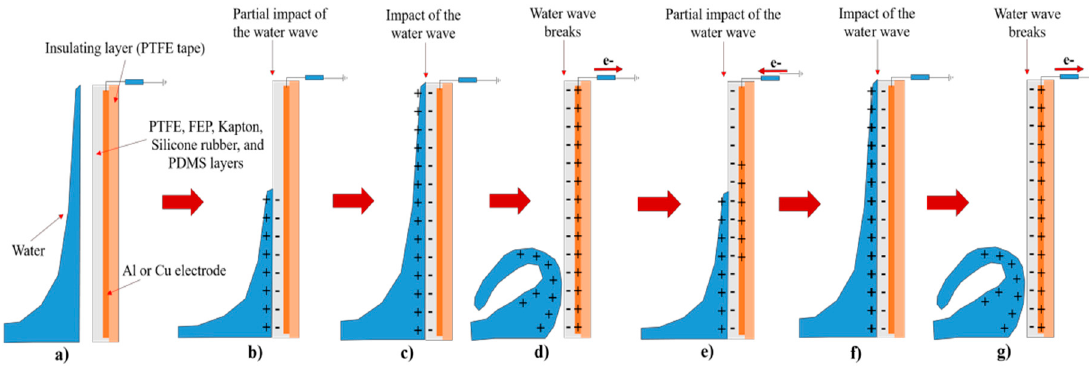
Figure 2. Working mechanism of the WDSE-TENG prototypes by the contact electrification of dielectric layers with water wave impact. ( a ) Before the dielectric layer makes contact with water, no charge transfer occurs. ( b ) The ionization of the surface groups on the dielectric layer will cause the dielectric layer to be negatively charged and ( c ) create a positively charged EDL on the contact surface of the water wave to maintain electrical neutrality. ( d ) The negative electric potential difference attains equilibrium as electrons flow to ground. ( e ) When another water wave contacts the negatively charged dielectric layer, establishes a positive electric potential difference as electrons will flow to the electrode, ( f ) until reaching a new equilibrium. ( g ) When the water wave breaks down and leaves the dielectric layer, another new equilibrium is achieved. ( a – g ) Once the following water wave contacts the WDSE-TENG prototype, a continuous output will be obtained.